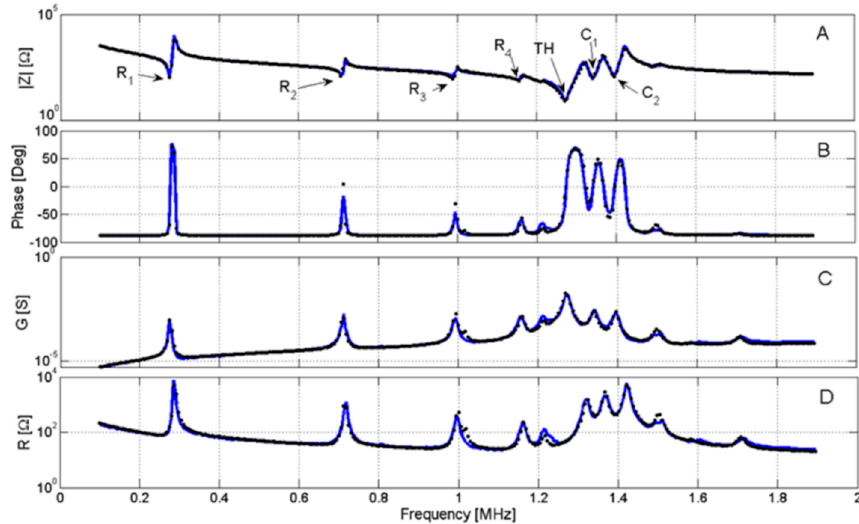
Figure 1. Experimental response at 35 °C (continuous blue line) and the numerical simulation using the optimized parameters (black dots). ( A ) Modulus of the electric impedance; ( B ) phase of the electric impedance; ( C ) electric conductance G; ( D ) electric resistance R. Fundamental radial resonance and overtones are indicated by a R n ( n = 1, 2, 3, 4), thickness resonance by a TH and the coupled modes by C m ( m = 1, 2).